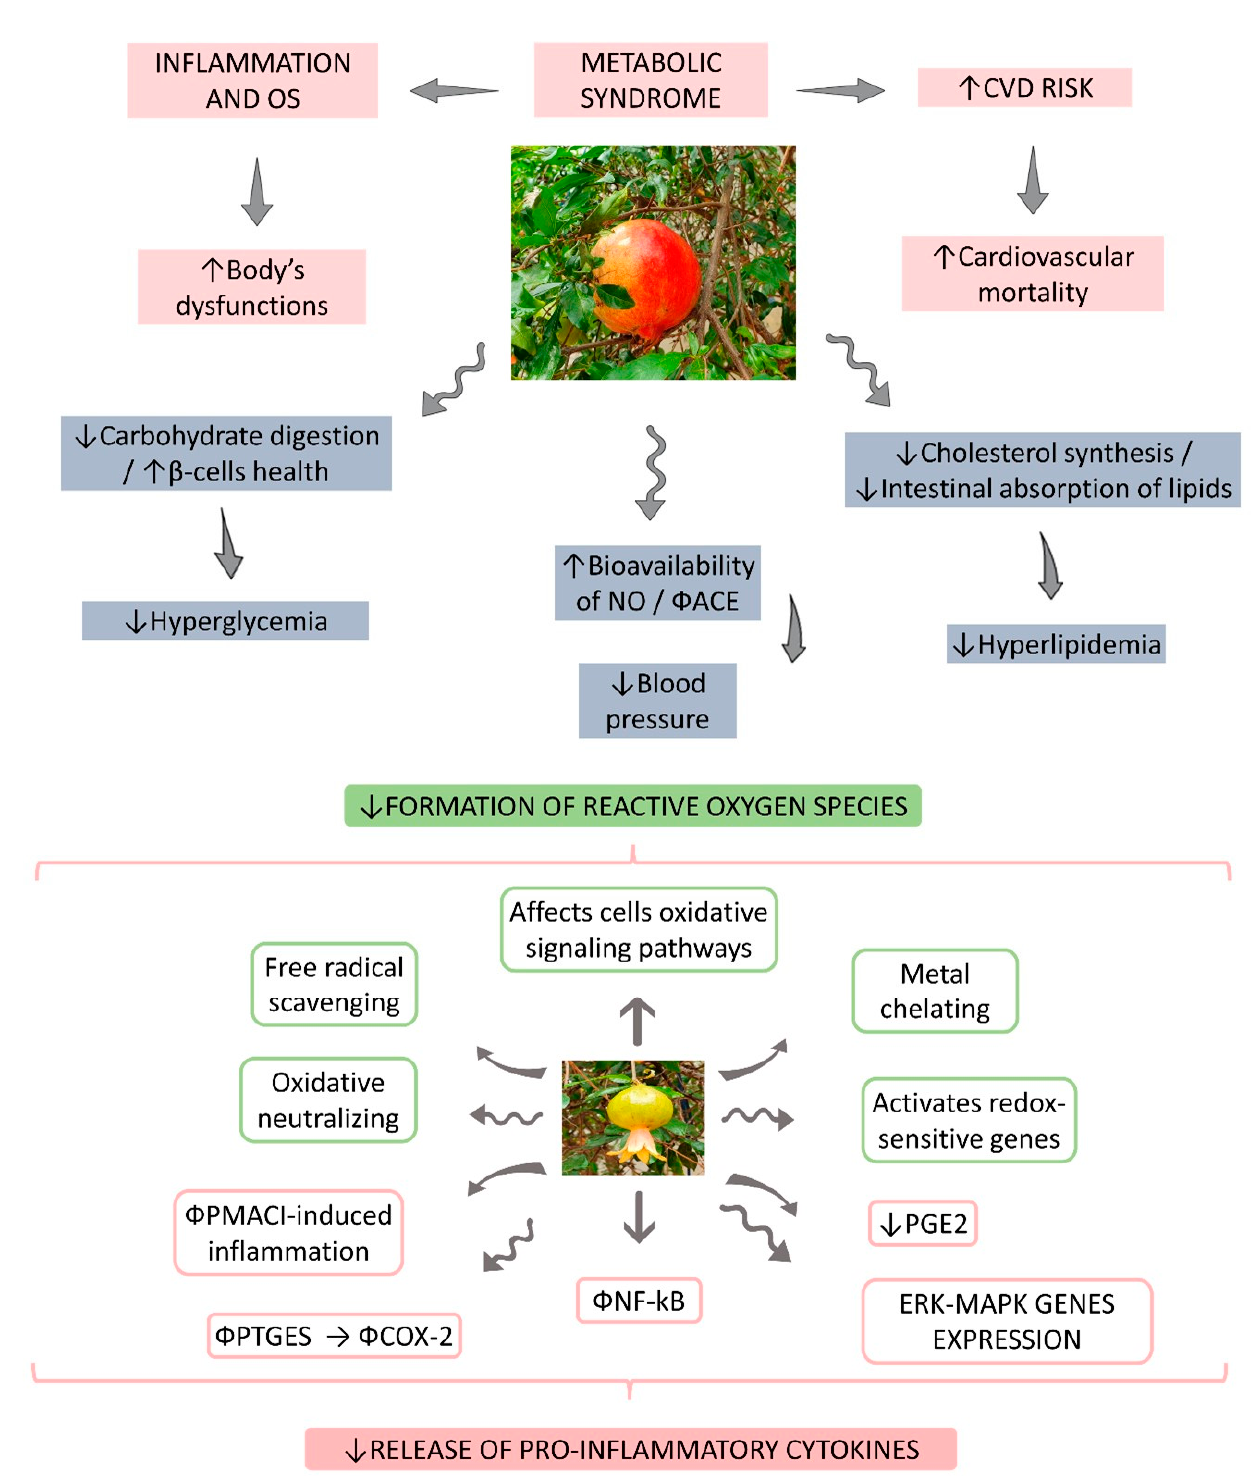
Figure 1. Metabolic syndrome and pomegranate: a blocking relationship. ↑ , increase; ↓ , decrease; Φ , impairment; β , beta; ACE, angiotensin converting enzyme; COX-2, cyclooxygenase; ERK, extracellular signal-regulated kinase; MAPK, mitogen-activated protein kinase; NF- κ B, nuclear factor- κ B; NO, nitric oxide; PMACI, phorbol 12-myristate 13-acetate and calcium ionophore; PGE2, prostaglandin E2; PTGES, prostaglandin E synthase.